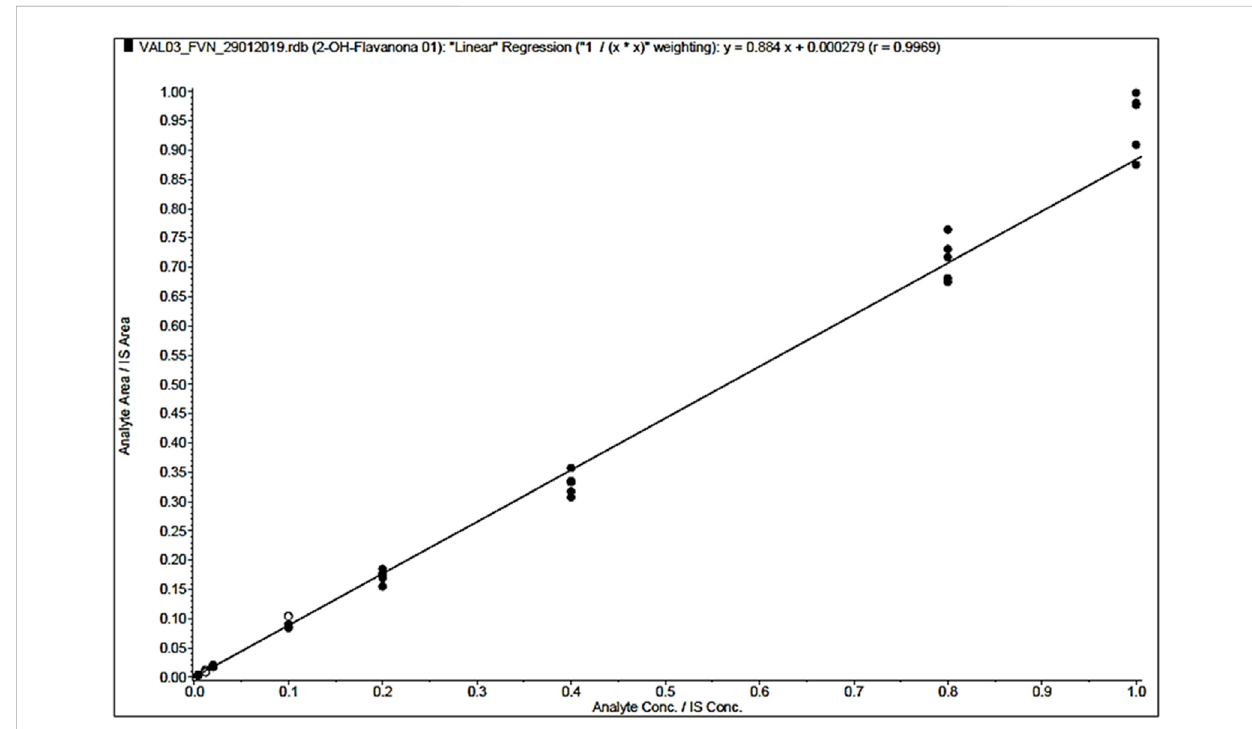
2 ′ -hydroxy fl avanone (2HF) linearitycurve: Representationofthevalues ofthecalibrationcurvewiththecoef fi cientswith thechosenweight(model 1/X 2 ). The calibration range was established at 1, 3, 5, 25, 50, 100, 200, and 250